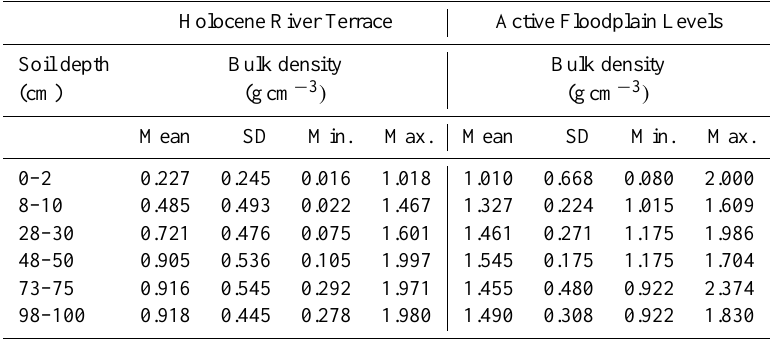
Table 2. Bulk densities for all six investigated soil layers at different depths and both geomorphic units, the Holocene river terrace and the active floodplain levels, expressed in gcm − 3 with the mean values and the respective standard deviations (SD) as well as the minima (Min.) and maxima (Max.).